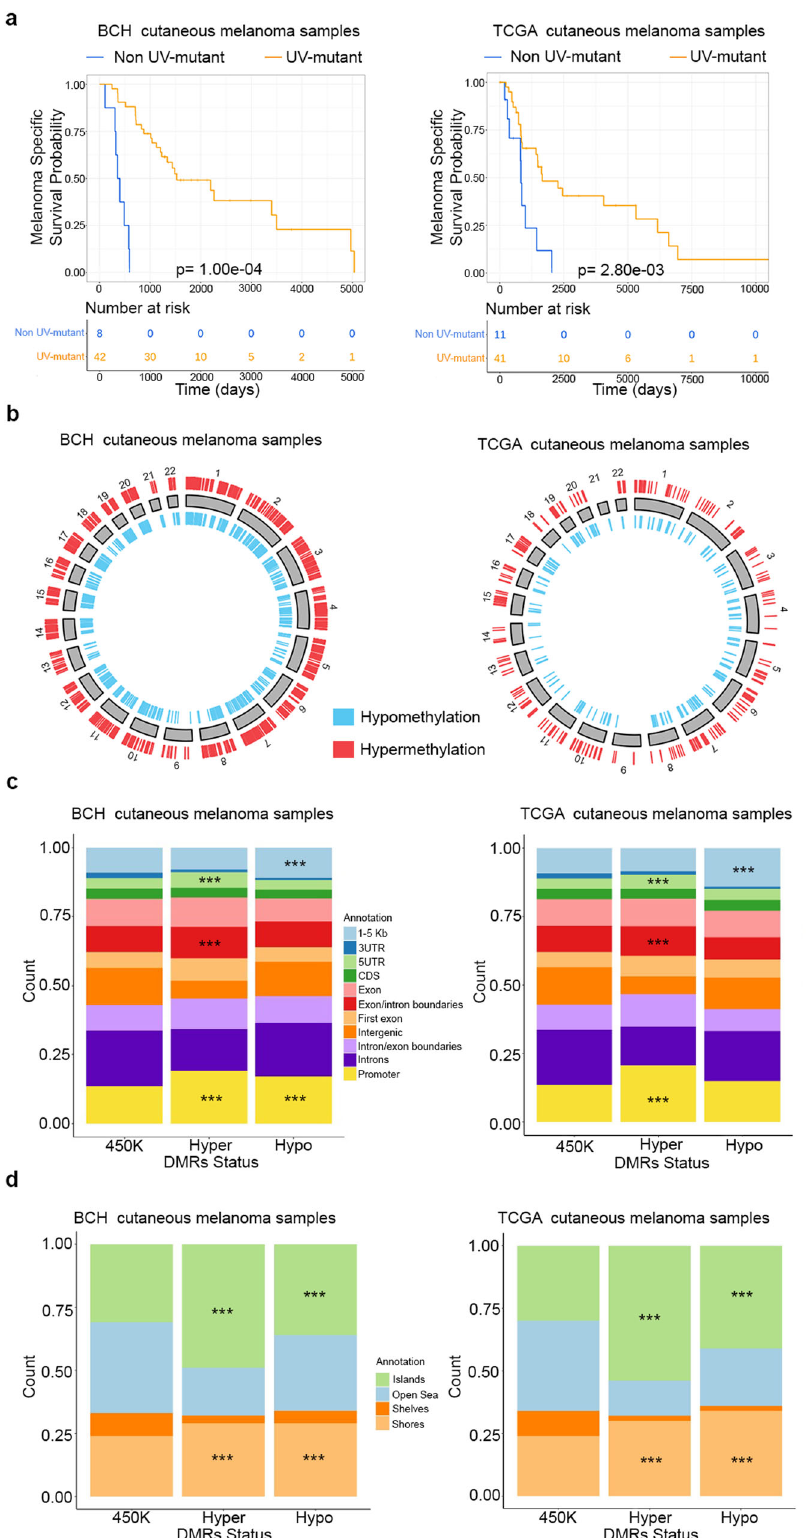
Fig. 2 Cross genome-methylome analysis of UV mutation signatures in cutaneous melanoma patients from BCH and TCGA cohorts. a Kaplan – Meier survival curves of melanoma patients by UV signature status in BCH ( n = 50) and TCGA ( n = 52). The P values were derived by log-rank test. Also shown are the DMR distributions from the crude model relative to chromosomal location ( b ), genomic regulatory regions ( c ), and CpG density regions ( d ) in both BCH ( n = 54) and TCGA ( n = 58). Enrichment analysis of hyper- and hypomethylated DMRs relative to the 450 K reference set in ( c , d ) was done using two-sided Chi-square test. *** p <